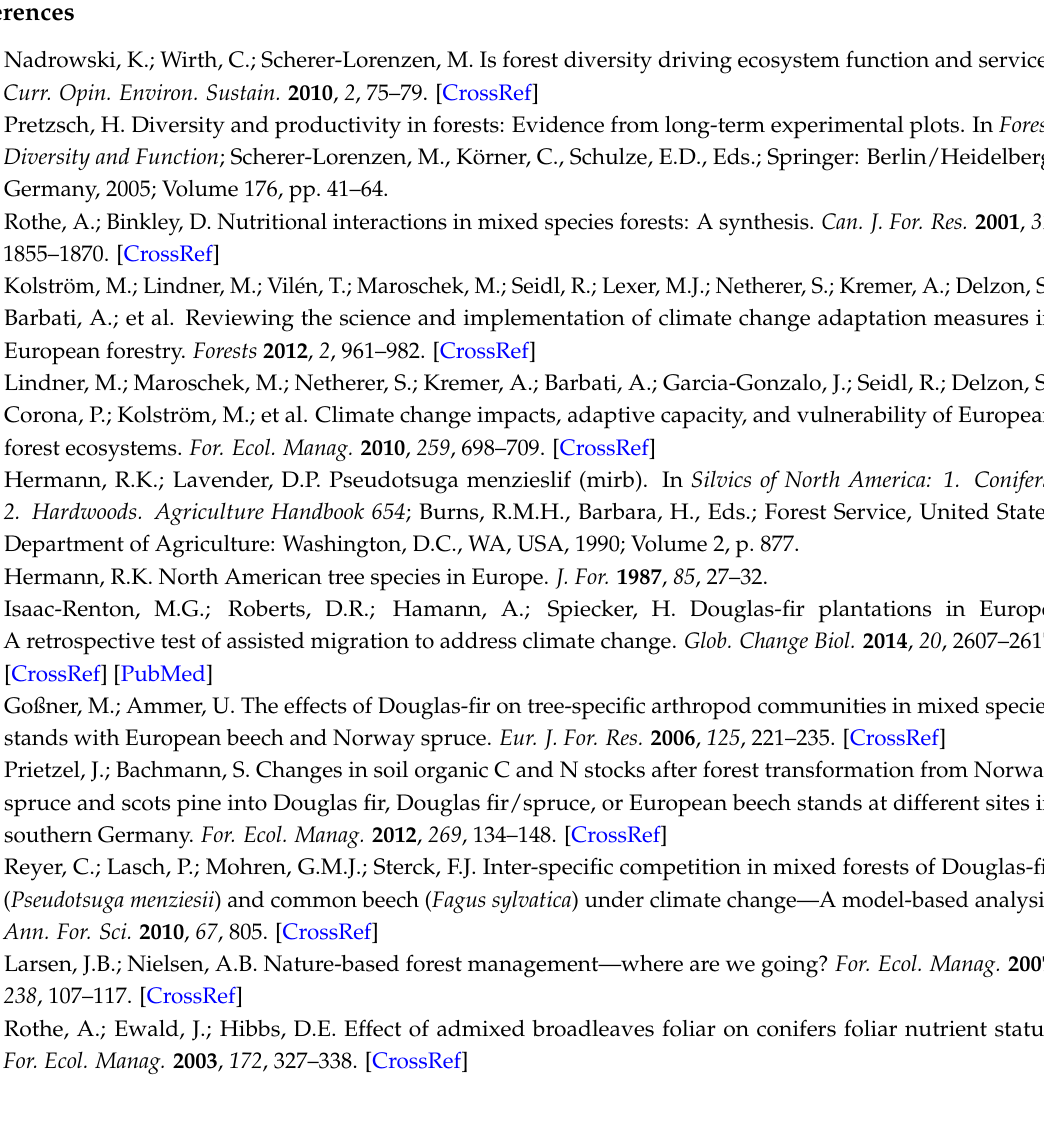
Table S1: Within site effects on soil C stock in CHR by soil layers; Table S2: Within site effects on soil C stock in LØV by soil layers; Table S3: Within site effects on soil N stock in CHR by soil layers; Table S4: Within site effects on soil N stock in LØV by soil layers; Table S5: Within site effects on soil C/N ratio in CHR by soil layers; Table S6: Within site effects on soil C/N ratio in LØV by soil layers; Table S7: Within site effects on soil pH in CHR by soil layers; Table S8: Within site effects on soil pH in LØV by soil layers; Table S9: Across site effects on soil C stock by soil layers; Table S10: Across site effects on soil N stock by soil layers; Table S11: Across site effects on soil C/N ratio by soil layers; Table S12: Across site effects on soil pH by soil layers; Table S13: R-squared values of across site models by soil layers and soil